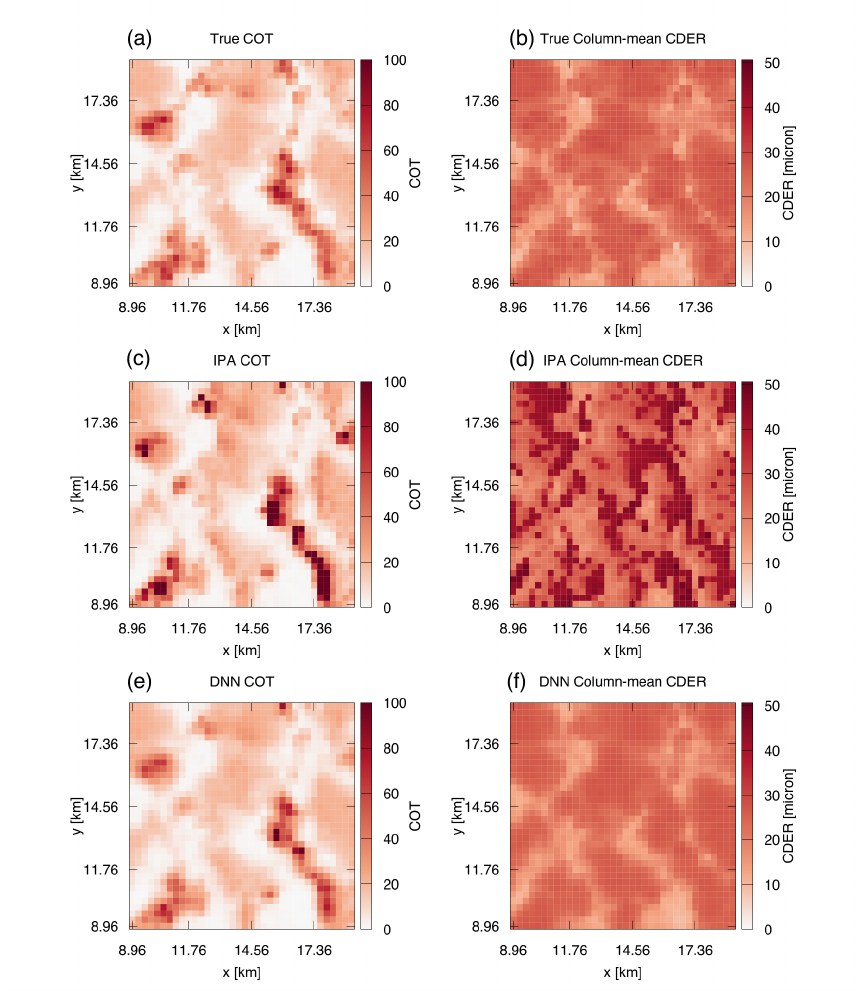
Figure 5. Examples of estimated (a, c, e) COT and (b, d, f) CDER of IPA and DNN retrievals for a view zenith angle of 0 ◦ . The sun is located on the left-hand side with an SZA of 60 ◦ . (a, b) True (reference) values of COT and CDER, (c, d) IPA retrievals, and (e, f) DNN-4w